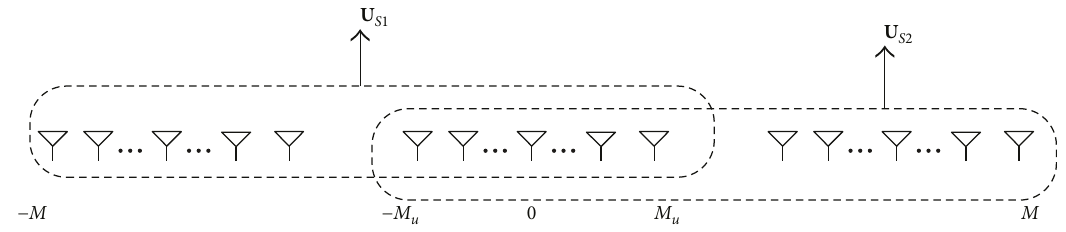
Figure 3: Construction of 2 subspace matrix elements for fi ne DOA